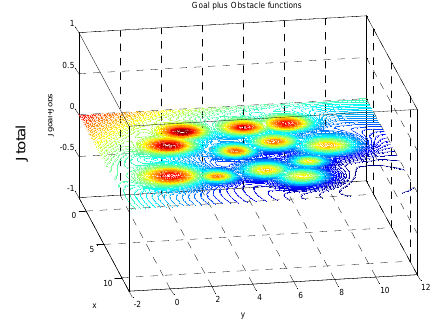
Fig. 8. Contour plot forCost function for case 2.